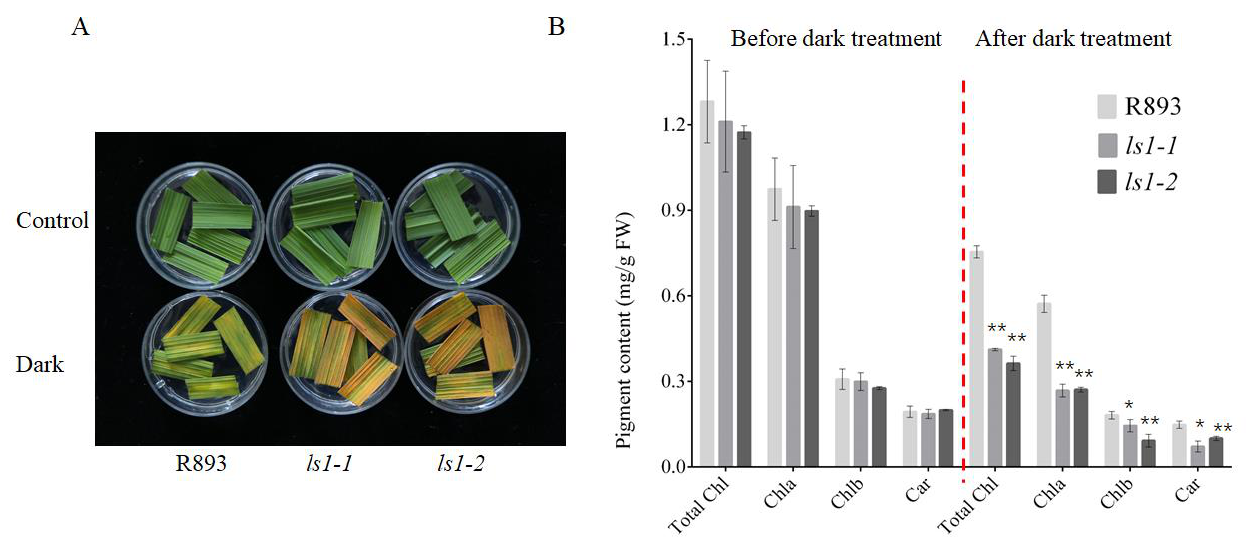
Figure 7. The ls1 plants exhibited accelerated leaf yellowing during dark-induced senescence. ( A ) Detached leaves of WT and ls1 plants were immersed in 15 mL ddH 2 O at 28 °C for 4 days in complete darkness. ( B ) Pigment contents of detached leaves of WT and ls1 plants before and after darkness treatment. The error bars indicate SDs of three biological replicates. The p -value was calculated using a Student’s t -test. ** p < 0.01, * 0.01 < p < 0.05.